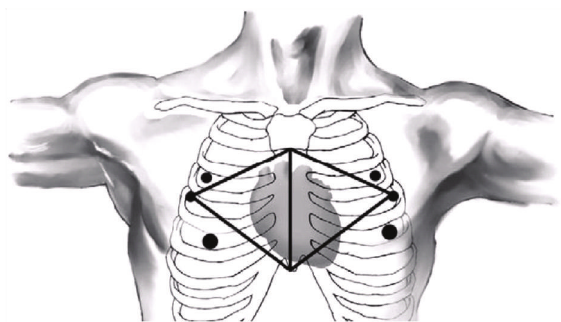
Figure 1: Port access for bilateral minimally invasive AF ablation. AF: atrial